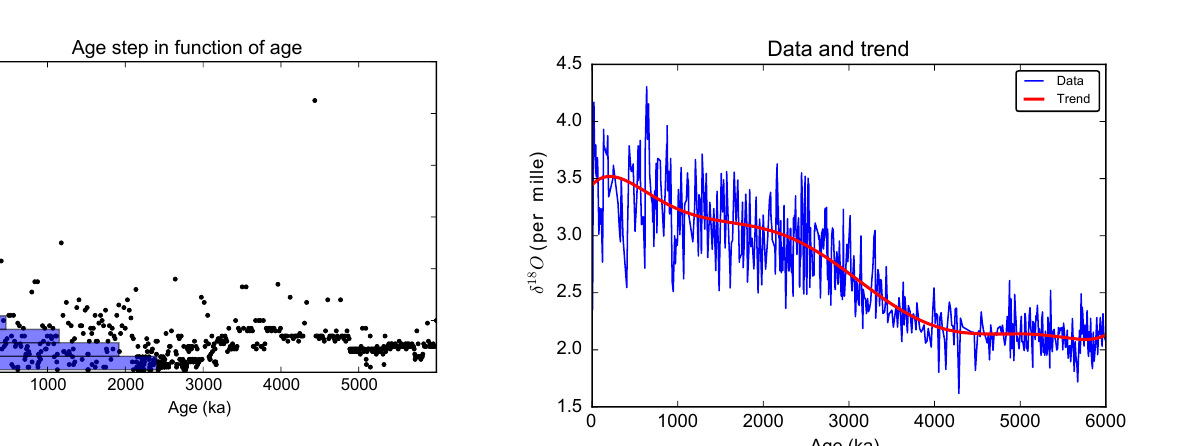
Fig. 8c. The MCMC confidence levels of Fig. 8d are computed from 50000 samples of the parameters, after skimming off a distribution with much more